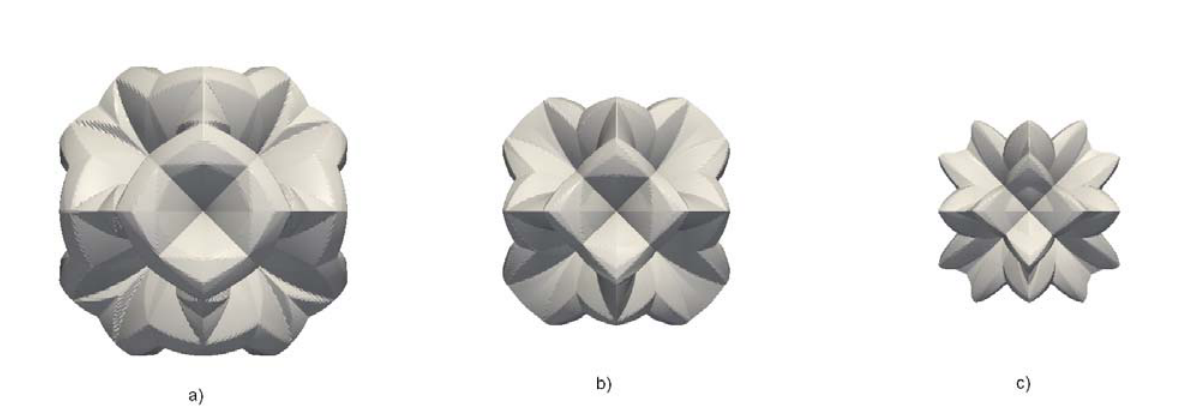
Figure 4. The angular dependence of the etching rate calculated using interpolation formulas with thirteen-parameters for three etchant concentrations: (a) 30%, (b) 40% and (c)